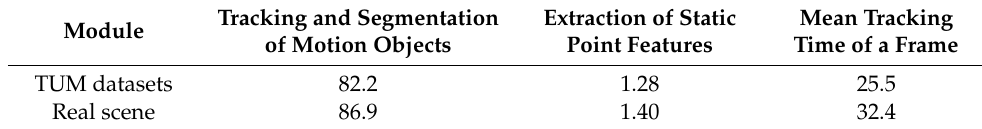
Table 8. The computation times of different parts in PFD-SLAM (Unit: ms).